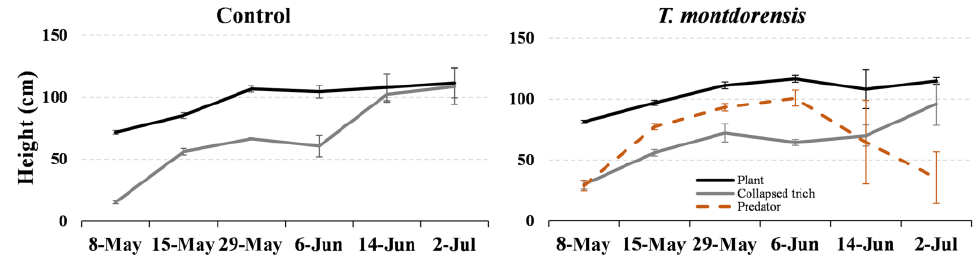
Figure 2. Height of the plant, maximum height at which collapsed trichomes were found, and maximum height at which T. montdorensis was found on each sampling date for the control and predator treatment.